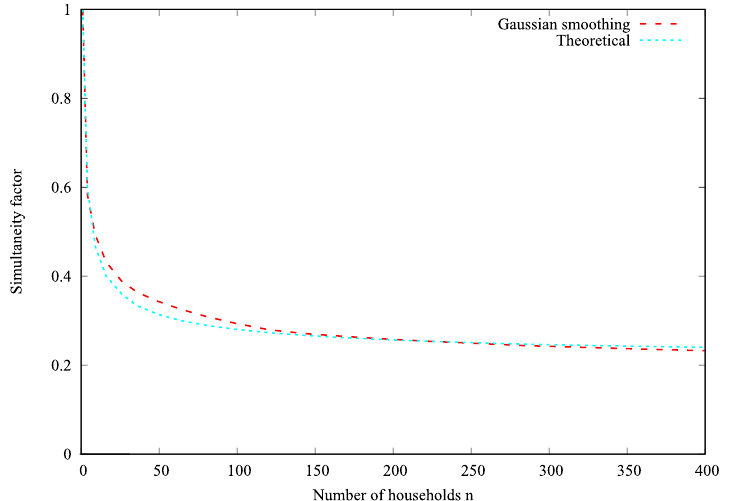
Figure 3. Comparison of simultaneity factors resulting from Gaussian smoothing and theoretical values with g ∞ =